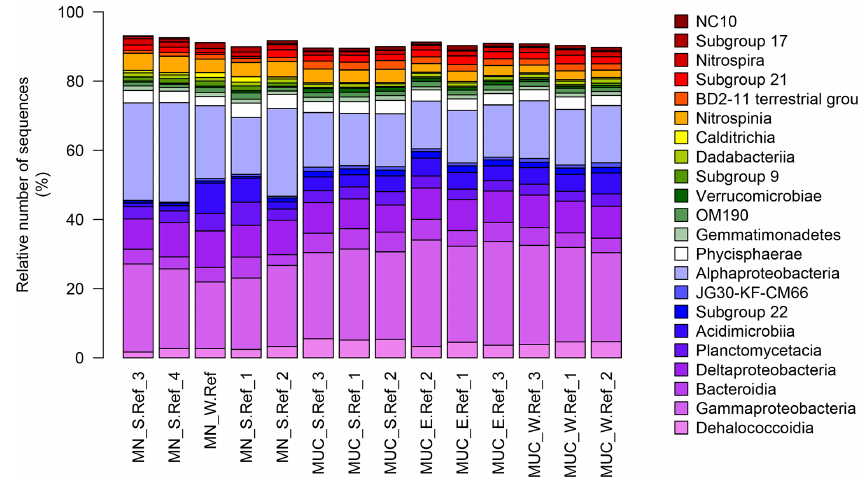
Figure 3. Bacterial-community structure at the dominant class level (cut-off of ≥ 1%). MN: manganese nodules; MUC: